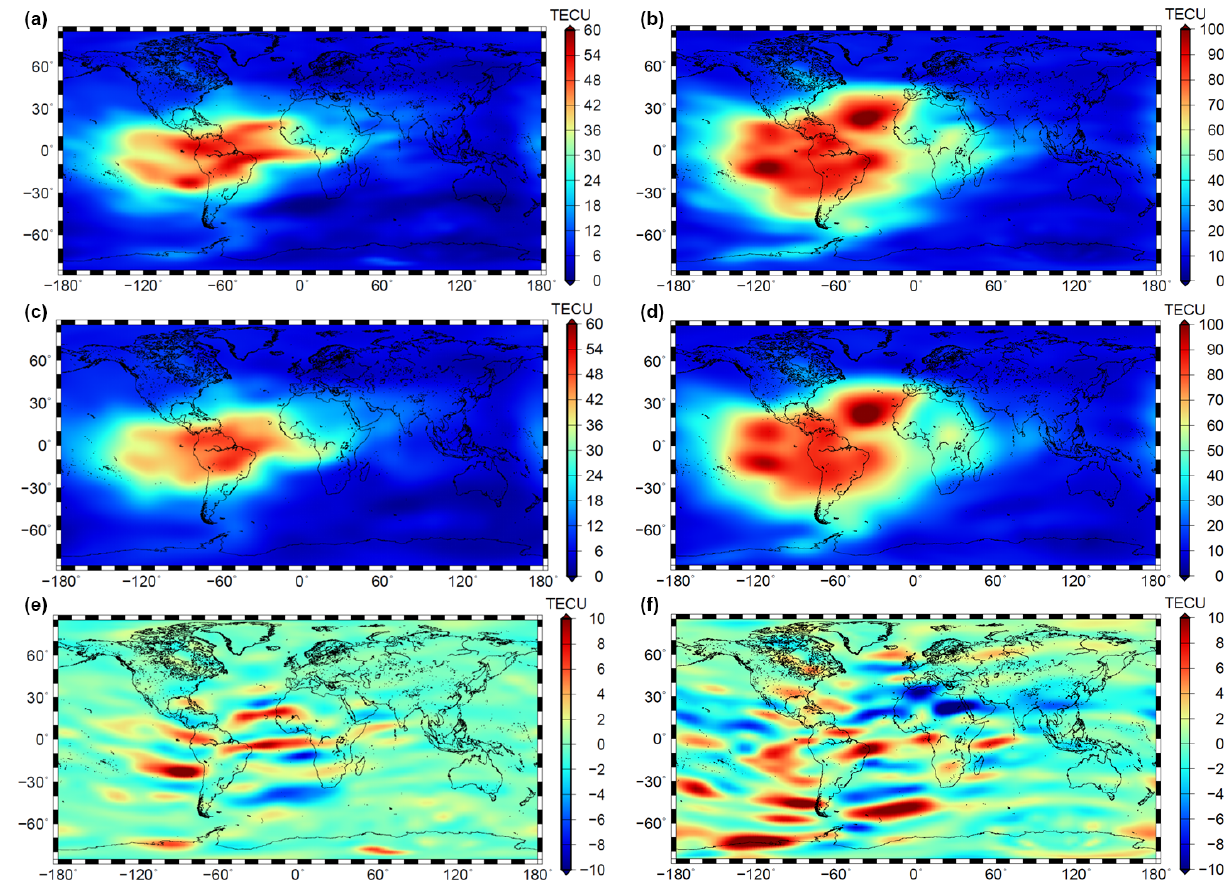
Figure 12. Multi-scale VTEC products for solar storm events: high-resolution VTEC map “ophg” for 8 September 2017 (a) and for 17 March 2015 (b) ; low-resolution VTEC map “oplg” for 8 September 2017 (c) and for 17 March 2015 (d) ; panels (e) and (f) show the detail signals introduced in equation block Eq. (68) and computed by means of Eq. (44) for the two solar events.